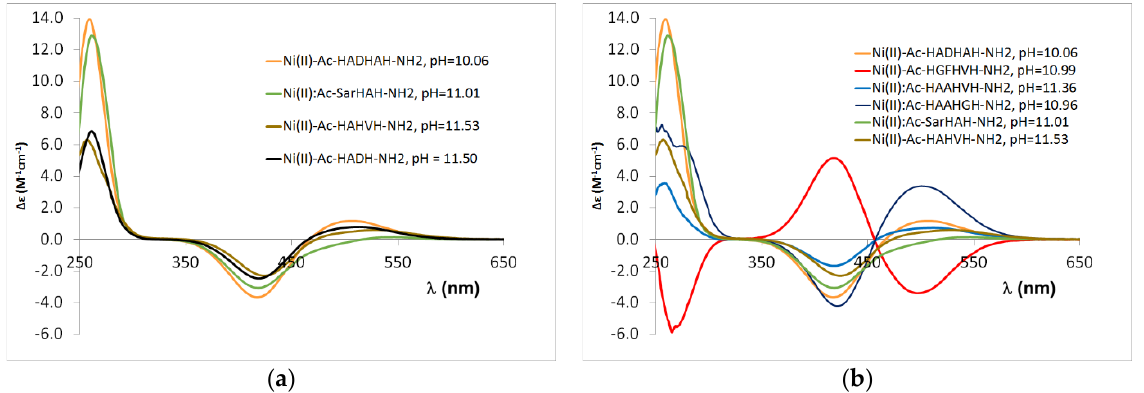
Figure 11. CD spectra registered in equimolar solution of Ni(II)-multihistidine peptide systems at pH 11.0–11.5; data of Ac-HAHVH-NH 2 from Ref. [9]. ( a ) CD spectra comparision of Ac-HADHAH- NH 2 , Ac-SarHAH-NH 2, Ac-HAHVH-NH 2 and Ac-HADH-NH 2 ; ( b ) CD spectra comparision of Ac-HADHAH-NH 2 , Ac-HGFHVH-NH 2 , Ac-HAAHVH-NH 2 , Ac-HAAHGH-NH 2 , Ac-SarHAH- NH 2 , Ac-HAHVH-NH 2